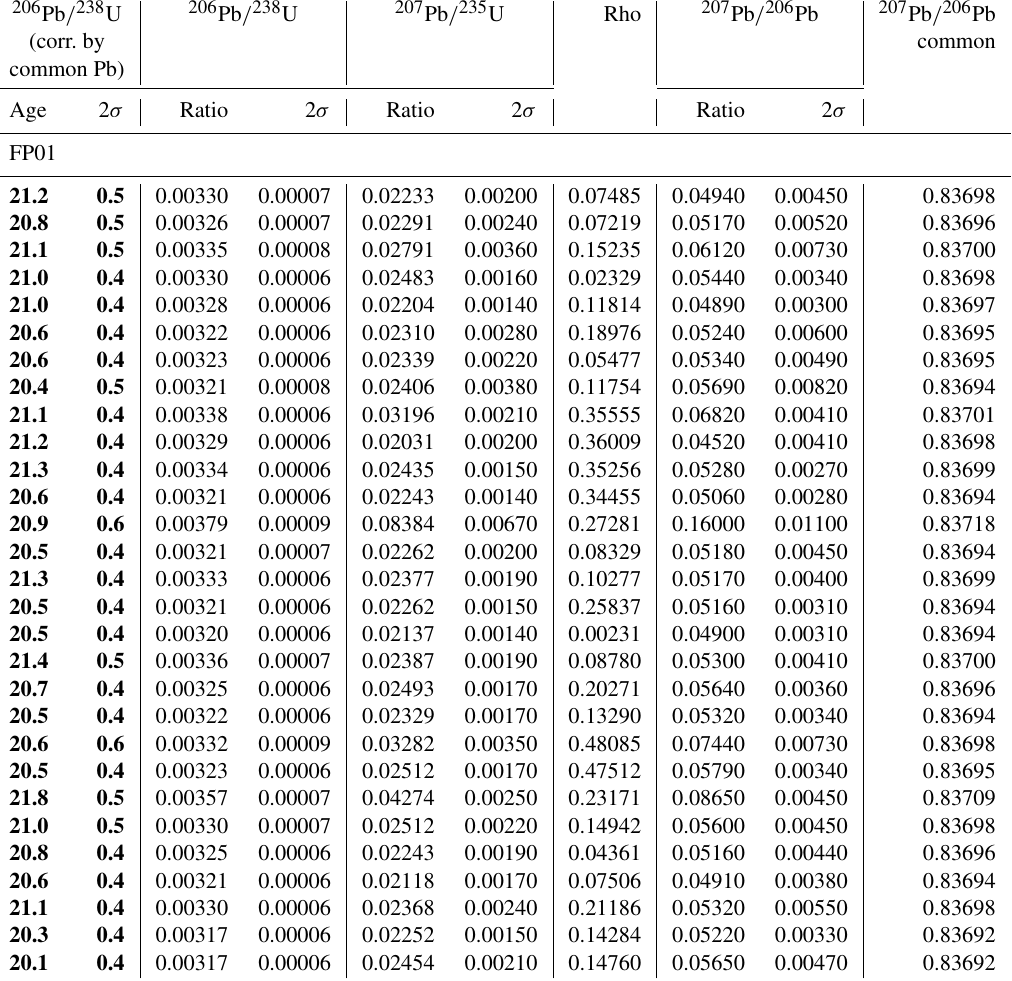
Table B1. U–Pb geochronology analytical data. Values in bold correspond to those used for age